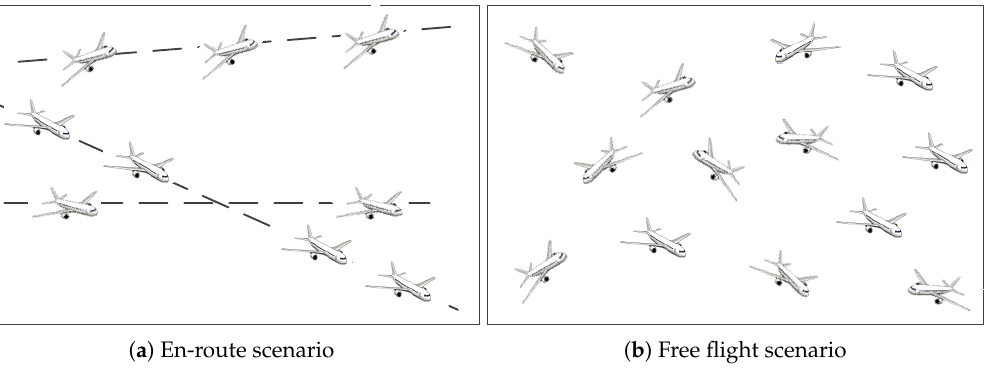
Figure 2. Aircraft flight